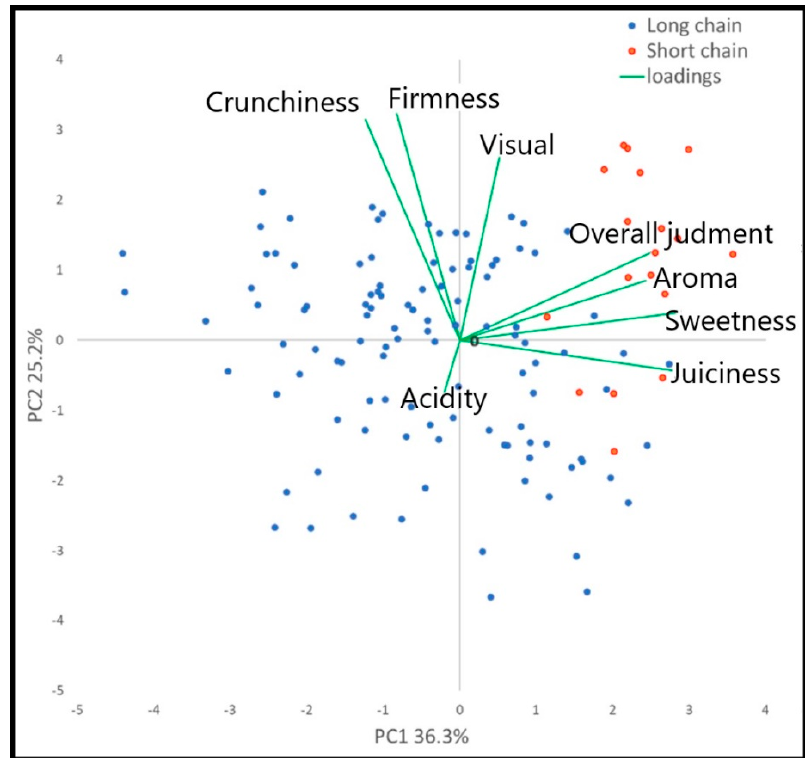
Figure 4. Scatter plot of the first two axes of the PCA conducted on panel test variables. Table 3. Acceptance of difference peach and nectarine fruits by Italian consumers harvested at “optimal maturity stage”. * Degree of liking: 1 = dislike extremely, 2 = dislike very much, 3 = dislike moderately, 4 = dislike slightly, 5 = neither like nor dislike, 6 = like slightly, 7 = like moderately, 8 = like very much, 9 = like extremely.